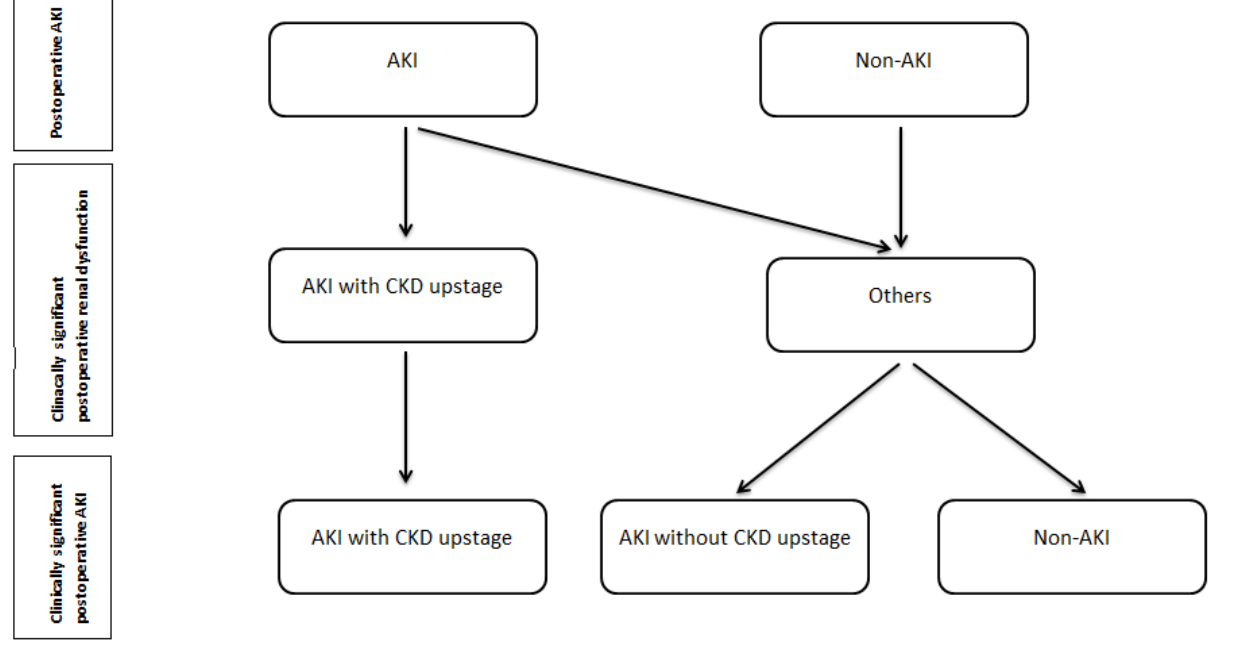
Figure 1. The study groups formation. Abbreviations: AKI–acute kidney injury; CKD–chronic kidney disease.